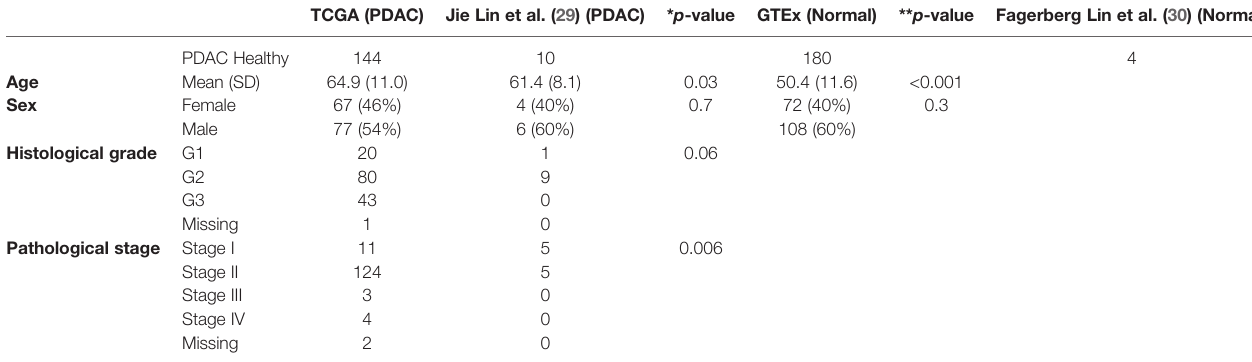
TABLE 1 | Patient/sample